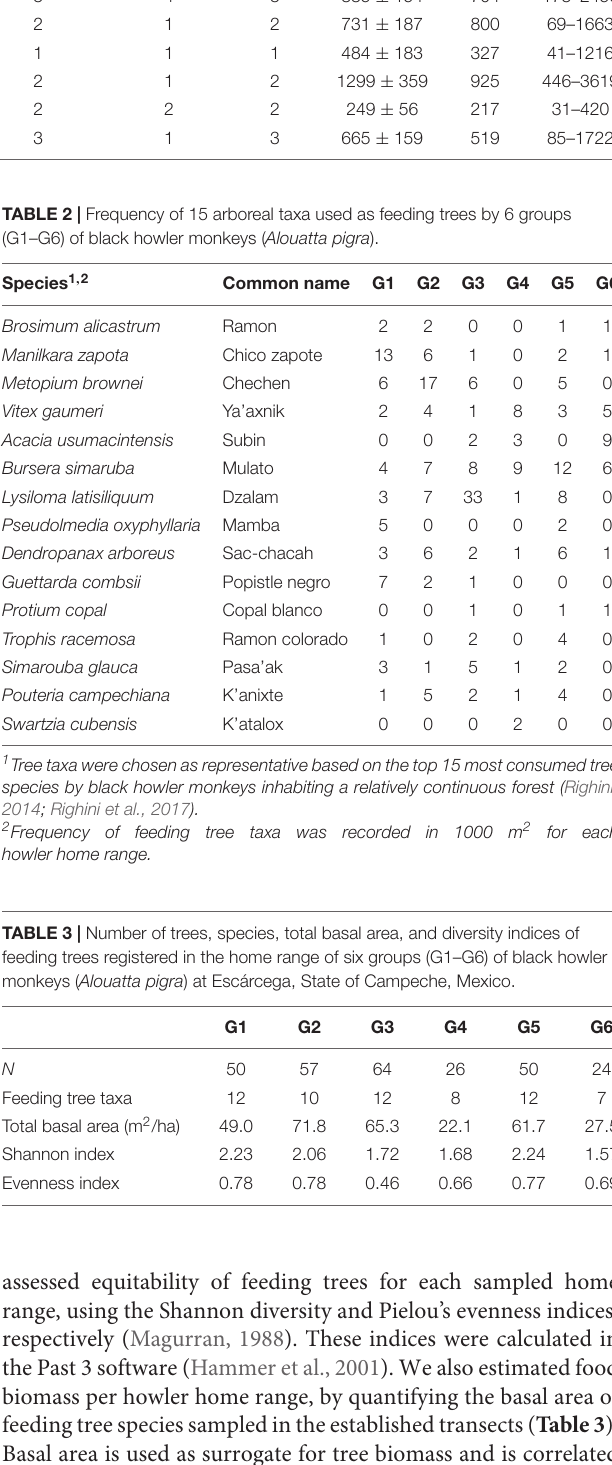
TABLE 1 | Size of fragments, home range, number of individuals, and concentrations (ng/g) of fecal glucocorticoid metabolites (fGCMs) of six groups of black howler monkeys ( Alouatta pigra ) from Escárcega, State of Campeche, Mexico. Fragment Group ID area (ha)